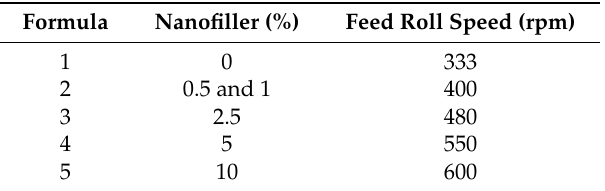
Figure 3. The mixture production device. Table 1. Feed roller speed.